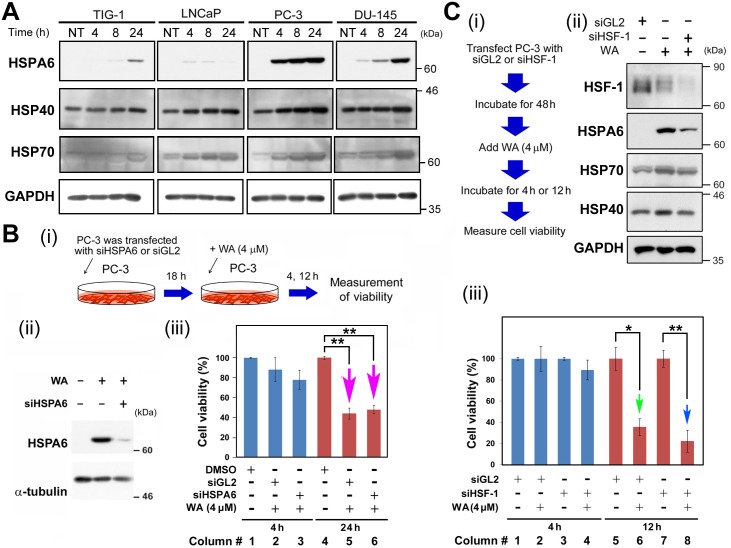
Expression of HSP genes is up-regulated after WA treatment.(A) Western blot analysis to detect HSPA6, HSP40, HSPA70, EGR-1, PAR-4, and GAPDH (loading control) in TIG-1, LNCaP, DU-145, and PC-3 cells at 0, 4, 8 and 24 h after 4 μM WA treatment. Arrow indicates the band for bona fide EGR-1. (B) Influence of siHSPA6 expression on PC-3 cell growth. (i) Schematic for this experiment. (ii) Western blot analysis to confirm the knockdown of HSPA6 protein by siHSPA6, relative to cells treated with siGL2 (negative control). (iii) Influence of siHSPA6 and siGL2 on PC-3 cell growth, with or without WA treatment. Arrow highlights the reduction in PC-3 cell growth. (C) Influence of siHSF-1 expression on PC-3 cell growth. (i) Schematics for this experiment. (ii) Western blot analysis to confirm the knockdown of HSP protein by siHSF-1, relative to cells treated with siGL2 (negative control), and to determine whether HSF-1 knockdown affected HSP protein levels by detection of HSPA6, HSP40, HSPA70, and GAPDH in PC-3 cells. (iii) Influence of siHSF-1 and siGL2 on PC-3 cell growth, with or without WA treatment. Arrow highlights the reduction in PC-3 cell growth. Data are represented as means ± SEM of three independent experiments; pink, green, and blue arrows indicate significant decreases in cell viabilities (*, P < 0.05; **, P < 0.01).